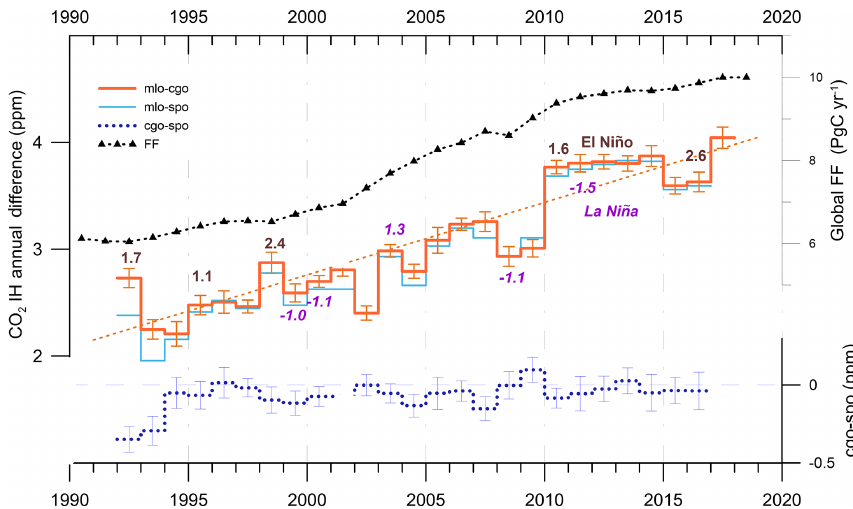
Figure 9. Annual changes in the baseline CO 2 difference between sites. Interhemispheric differences mlo–cgo (orange, with dashed linear regression) and mlo–spo (light blue) are plotted on the left axis. The peak magnitudes of strong El Niños (brown, ONI index >1) and strong La Niñas (purple, ONI index < − 1) are indicated. The cgo–spo annual differences are plotted on a doubled right-hand scale. Annual fossil fuel emissions from FF18, are shown on the top right